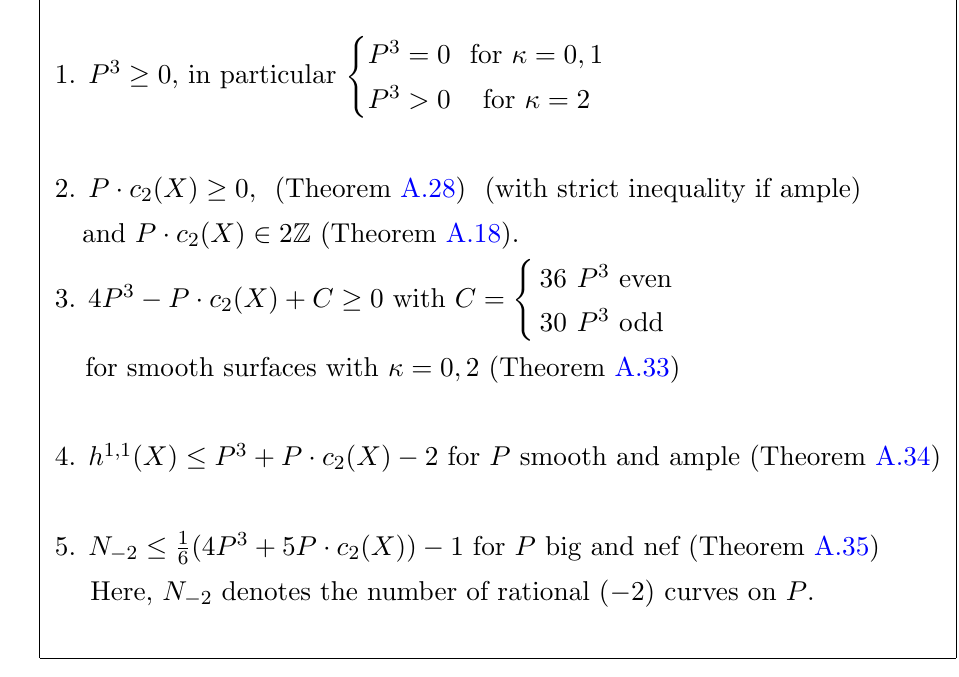
Table 2 . Conditions that the surface P needs to satisfy depending on its general